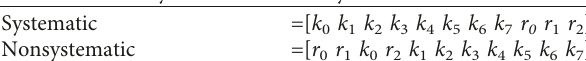
Table 2: Systematic and nonsystematic codewords. Systematic